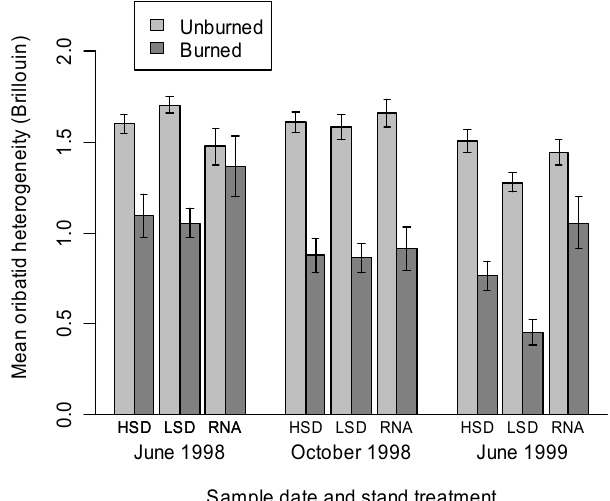
Figure 5. Mean oribatid mite assemblage heterogeneity (Brillouin index) ± SE in burned